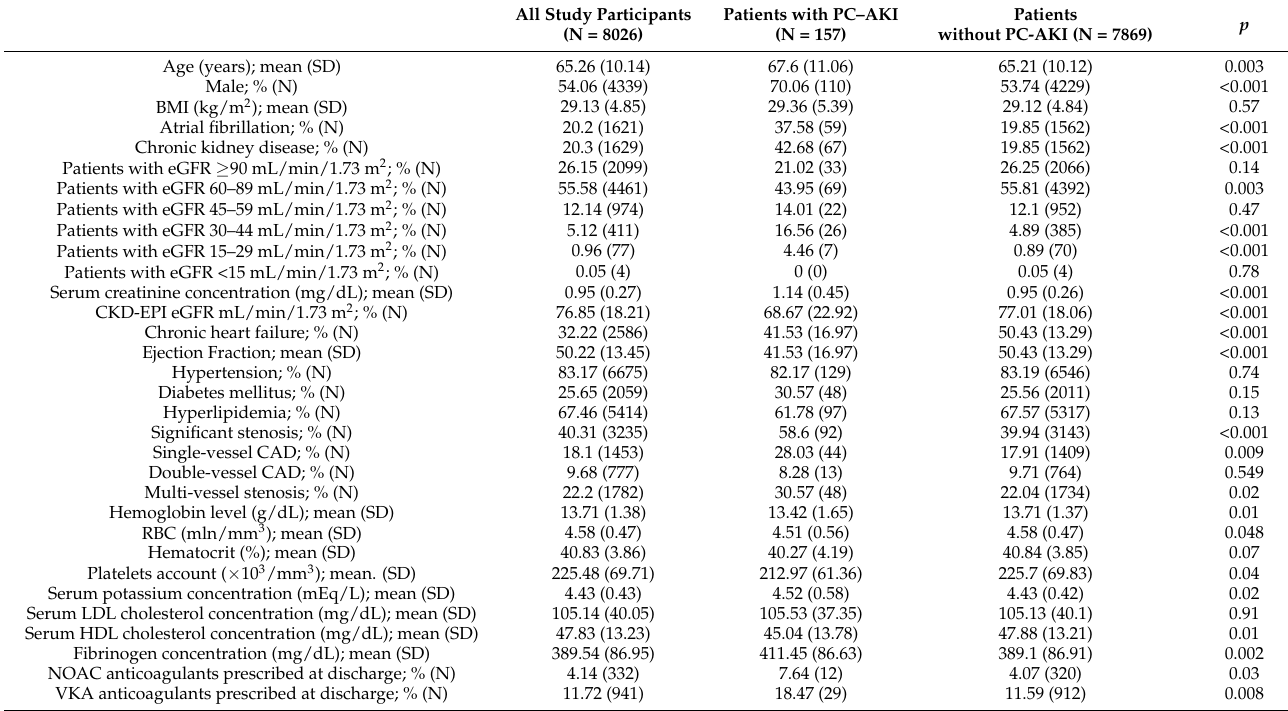
BMI, body mass index; CAD, coronary artery disease; CKD, chronic kidney disease; eGFR, estimated glomerular filtration rate; HDL, high density lipoprotein; LDL, low density lipoprotein; NOAC, non-vitamin K oral anticoagulants; PC–AKI, post-contrast acute kidney injury; RBC, Red blood cells; VKA; vitamin K antagonists.